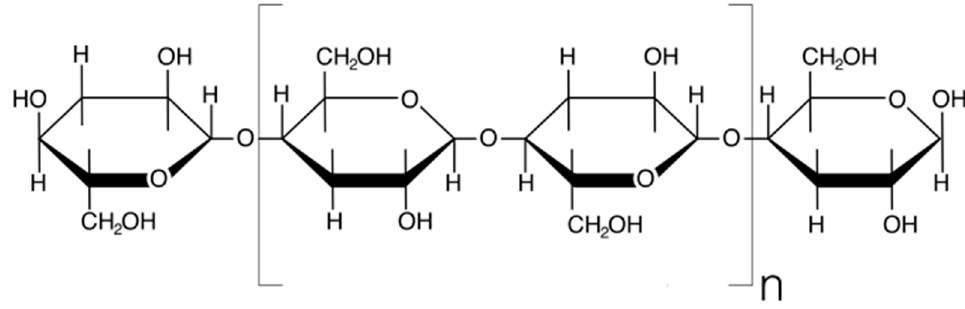
Figure 28. Chemical structure of the polysaccharide cellulose, note the glycosidic linkages between the glucose repeating units.